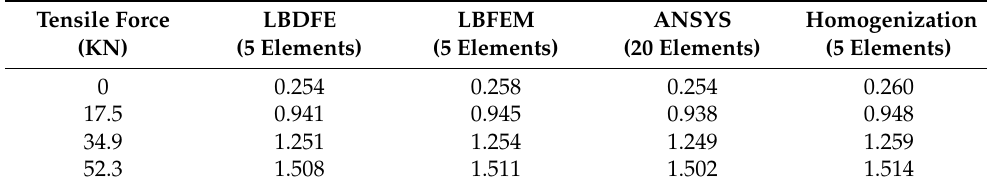
Table 3. Fundamental frequency of prestressed cantilevered FML beam in Hertz, subjected to various axial loads and end moment of 52.5 KN · m.